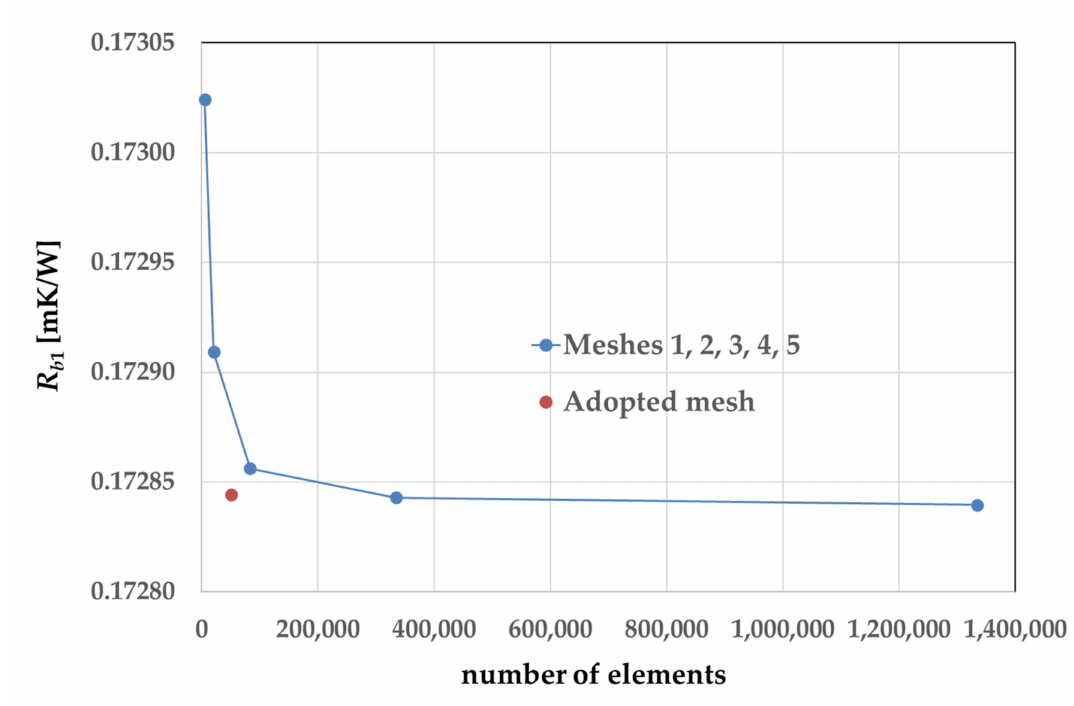
Figure 4. Values of R b 1 obtained by Meshes 1, 2, 3, 4, and 5, having 5214, 20,856, 83,424, 333,966 and 1,334,784 elements respectively, and with the adopted mesh, having 50,872